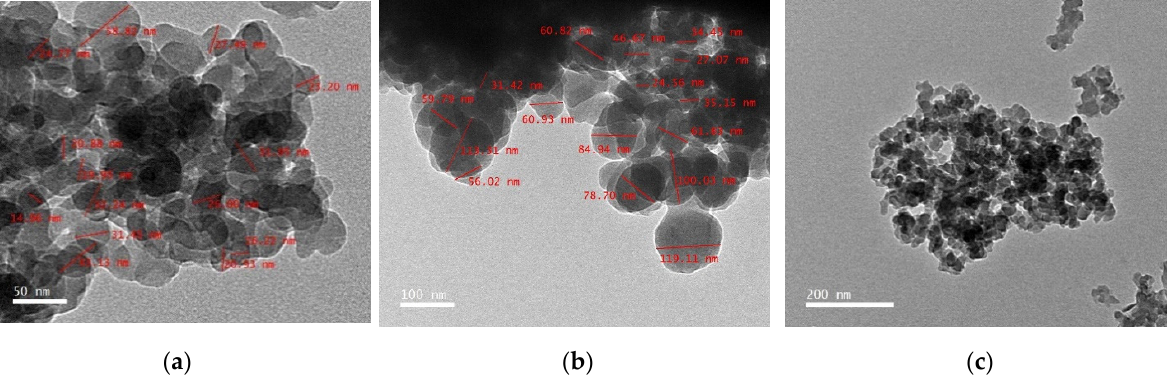
Figure 2. The nano-particles size and shape of the nano-zeolite by transmission electron microscope (TEM): ( a ) TEM with 50 nm; ( b ) TEM with 100 nm; ( c ) TEM with 200 nm.